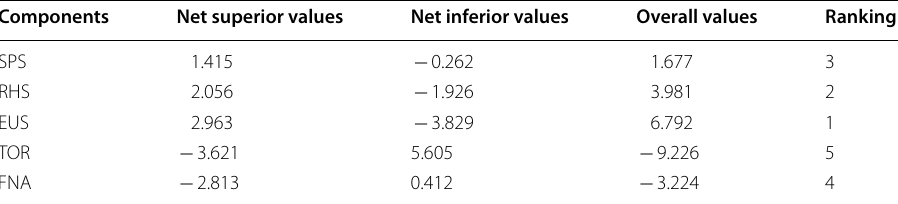
Table 18 Net superior, inferior, and overall values of the components Components